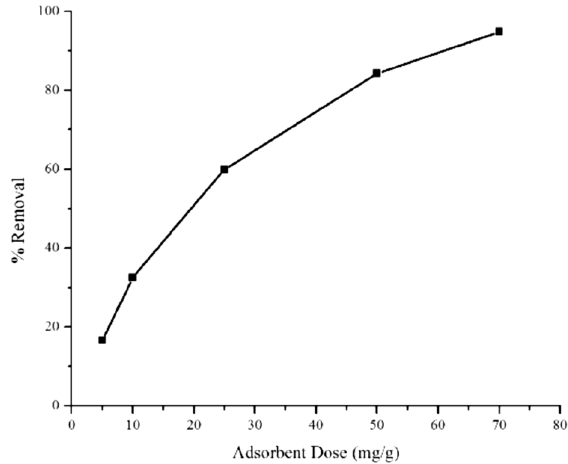
Figure 11. Adsorbent dose effect on %Removal of MB by NSG.